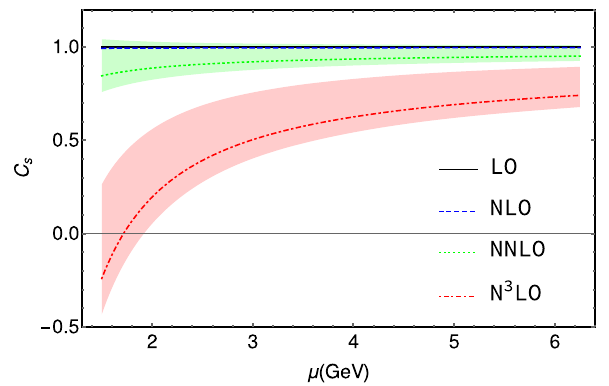
Fig. 4 The renormalization scale dependence of the matching coeffi- cient C s at the LO, NLO, NNLO and N 3 LO accuracy. For details see the text